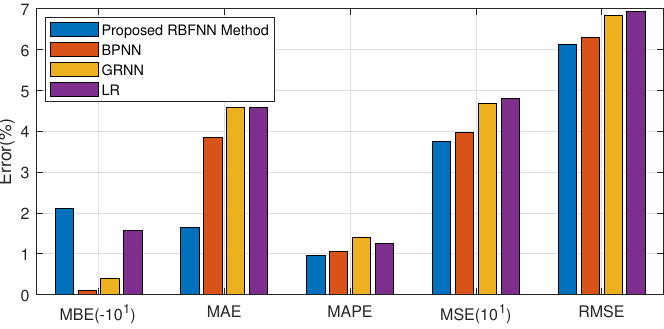
Figure 10. Comparative performance of the proposed